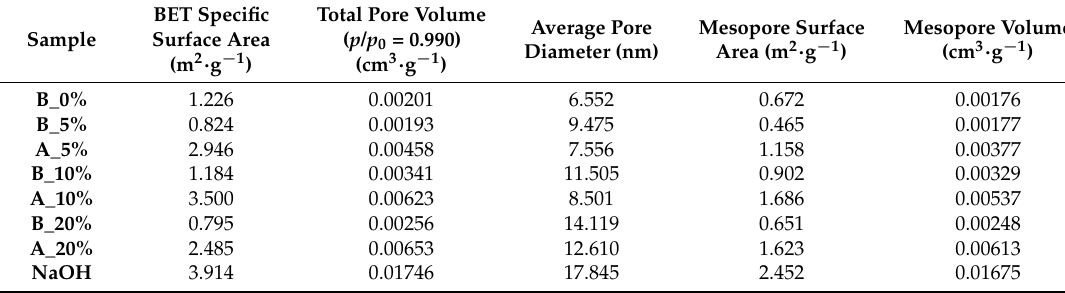
Brunauer–Emmett–Teller (BET) Surface Area and Pore Volume Analysis of Food-Waste-Derived Biochar with Different NaCl